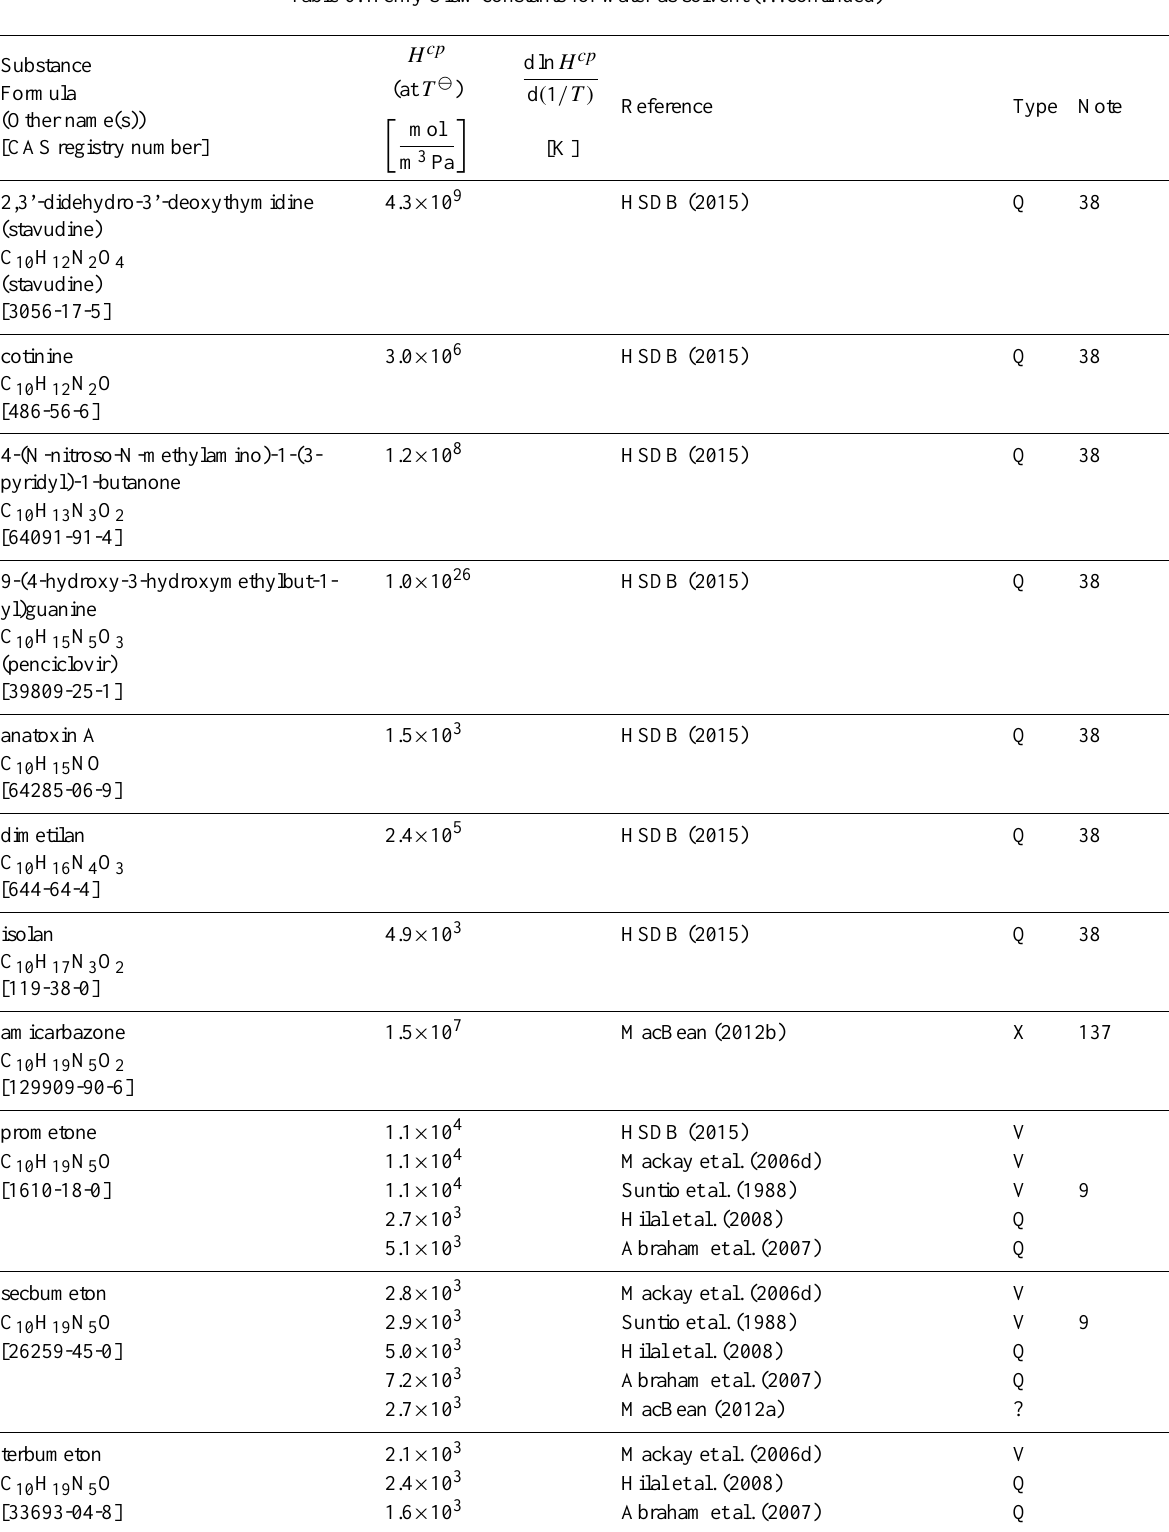
Table 6: Henry’s law constants for water as solvent